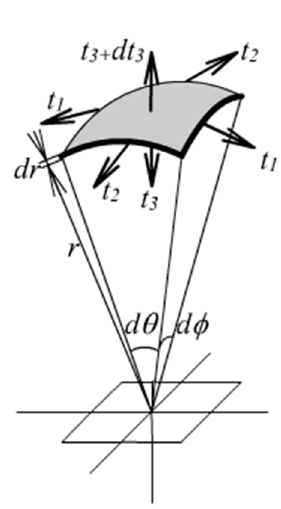
Figure 11. Radial equilibrium of a thick-walled balloon.